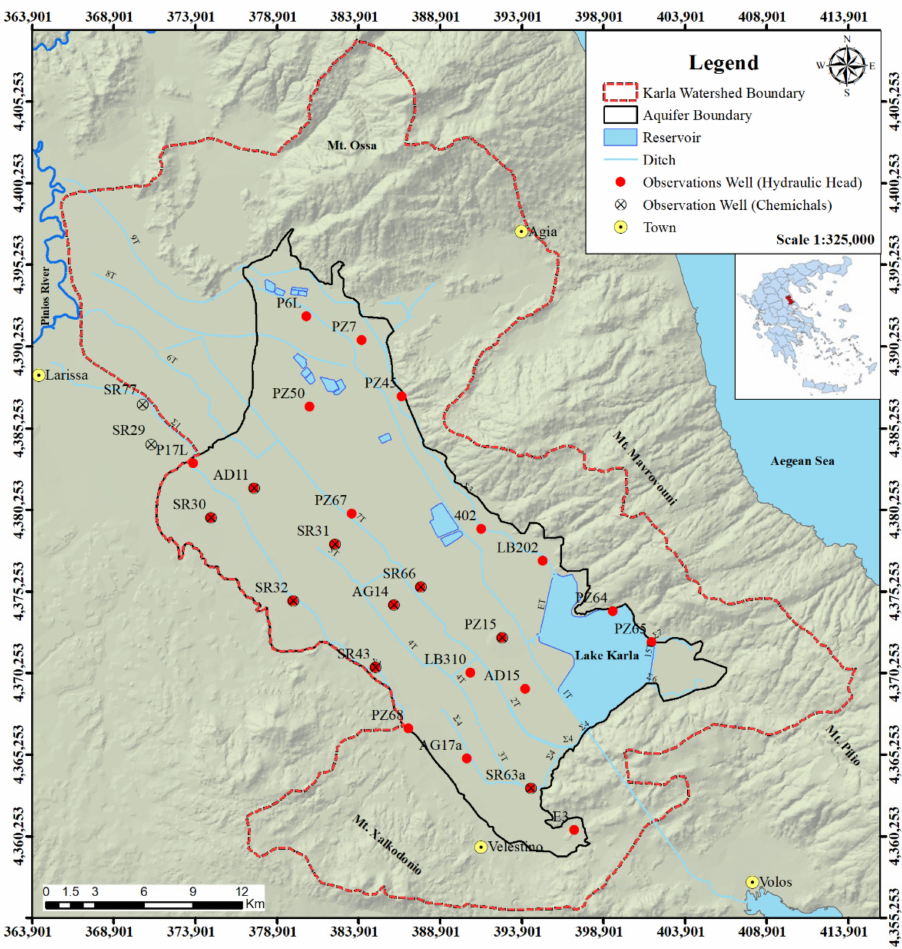
Figure 1. Map of Lake Karla watershed, aquifer, and locations of groundwater monitoring